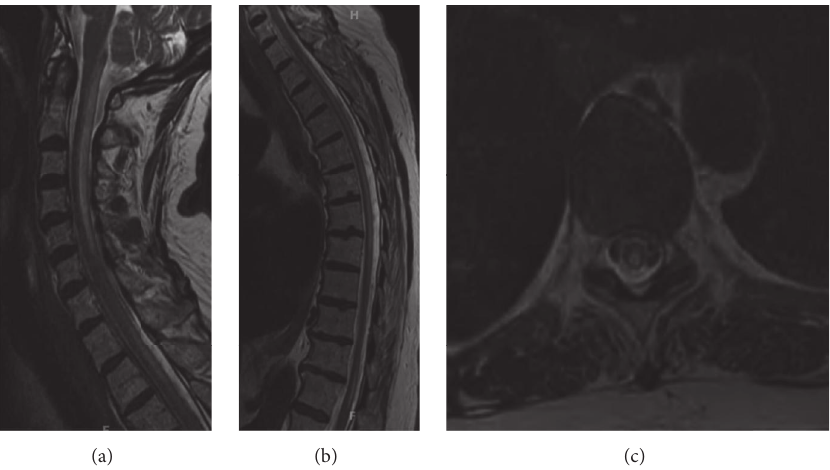
Figure 1: Sagittal T2-weighted MR images through the cervical (a) and thoracic (b) spine demonstrate diffuse, hyperintense signal in the posterior columns, extending nearly the entire length of the spinal cord. An axial T2W image at T9-T10 (c) demonstrates the cross-sectional extent of the signal